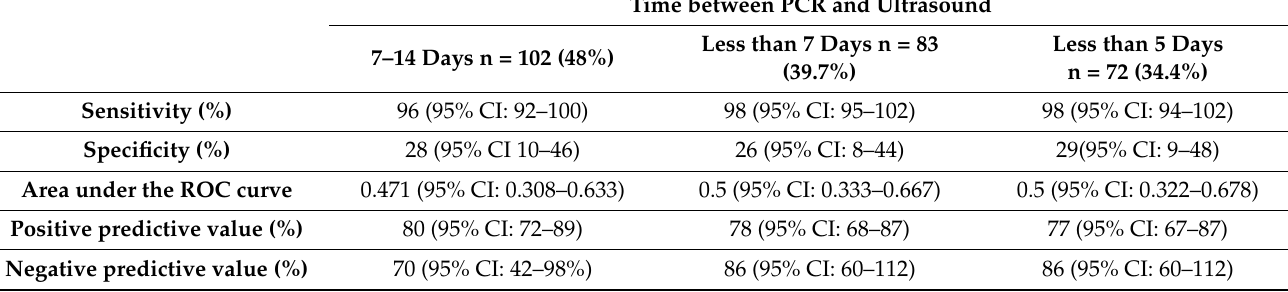
Table 4. Sensitivity, specificity, area under the curve, positive predictive value and negative predictive value as a function of time between PCR and ultrasound.